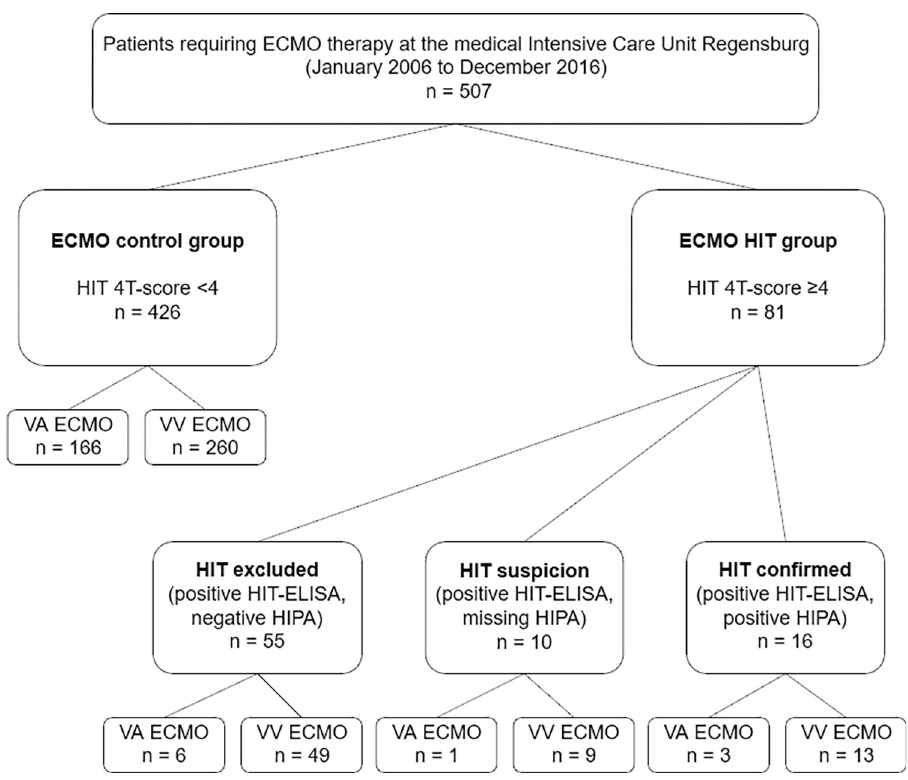
Fig 1. Flowchart of the study. Flowchart of the observational study evaluating heparin-induced thrombocytopenia (HIT) of the prospective extracorporeal membrane oxygenation (ECMO) registry Regensburg. VA: veno-arterial; VV: veno-venous; ELISA: enzyme-linked immunosorbent assay; HIPA: heparin induced platelet aggregation.